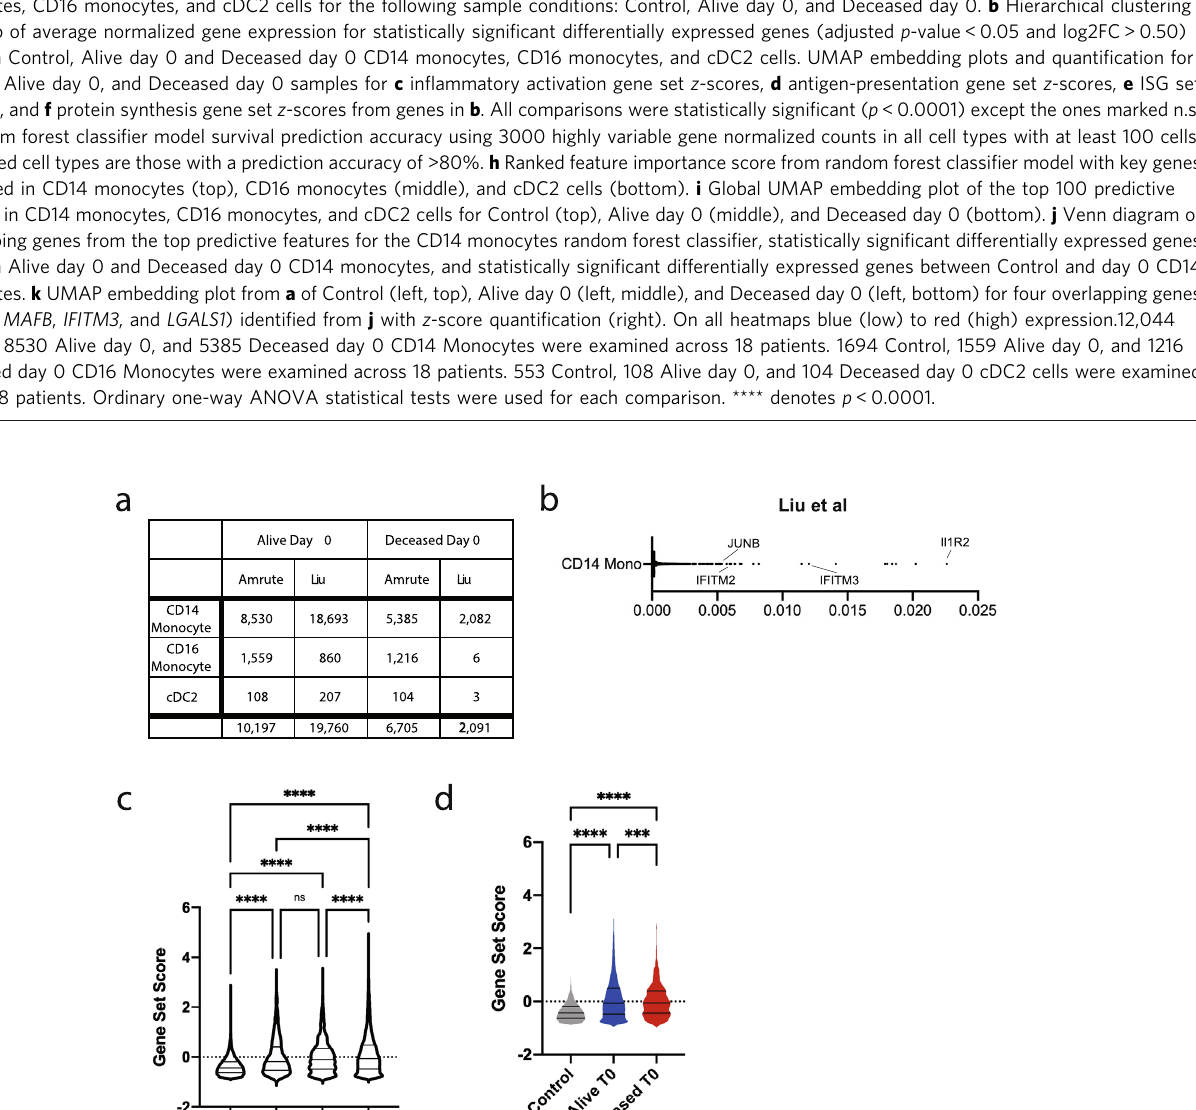
Fig. 5 Cross-validation of random forest predicted gene signature in an independent cohort of critical COVID. a Number of CD14 monocytes, CD16 monocytes, and cDC2 cells sequenced by outcome in this study and that by Liu et al. 19 . b Ranked feature importance score from random forest classi fi er model with key genes annotated in CD14 monocytes in the critically ill cohort in Liu et al. 19 . z -score for CEBPD , MAFB , IFITM3 , and LGALS1 in CD14 monocytes from Liu et al. 19 c By disease severity pooled at day 0 and d by survival outcome at day 0 (healthy controls, n = 14, and critically ill patients, n = 25; 21 alive and 4 deceased). 13,464 Control, 1297 Moderate day 0, 2798 Severe day 0, and 20,775 Critical day 0 CD14 Monocytes were examined. Ordinary one-way ANOVA statistical tests were used for each comparison. ns denotes not signi fi cant and **** denotes p <